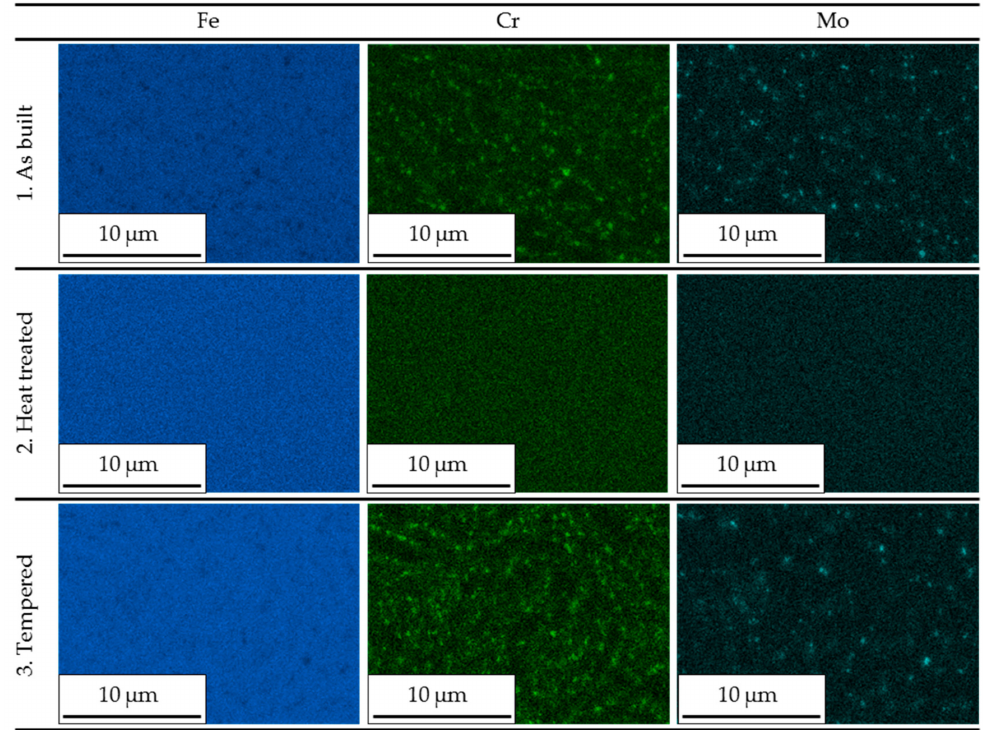
Figure 9. Energy-dispersive X-ray (EDX)-analysis of the distribution of the main alloying elements ferrite, chromium and molybdenum inside the microsructure of additively-manufactured hot work tool steel X37CrMoV5-1 after different heat treatments in ( 1 ) as bulit, ( 2 ) heat treated and ( 3 ) tempered